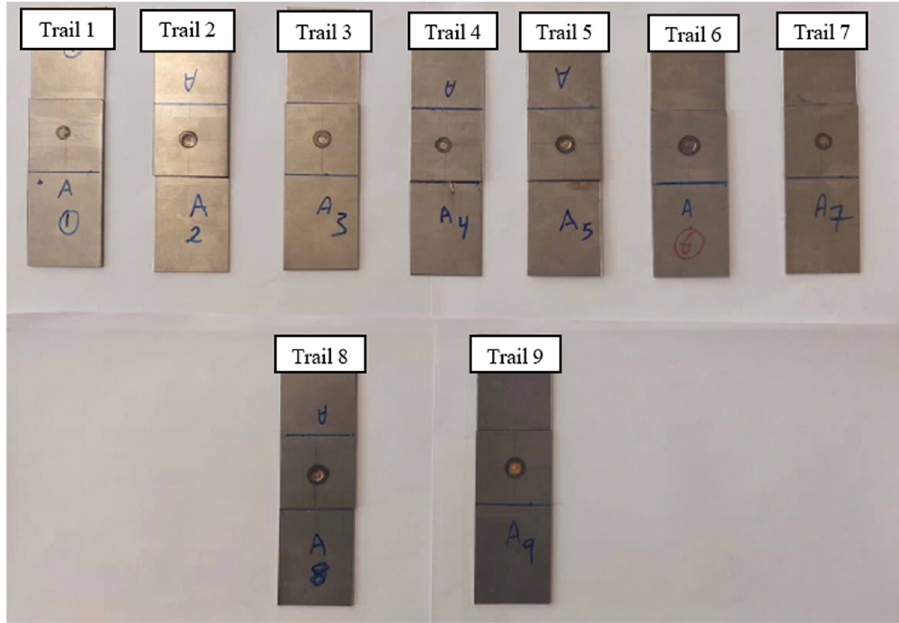
Figure 9: Welded